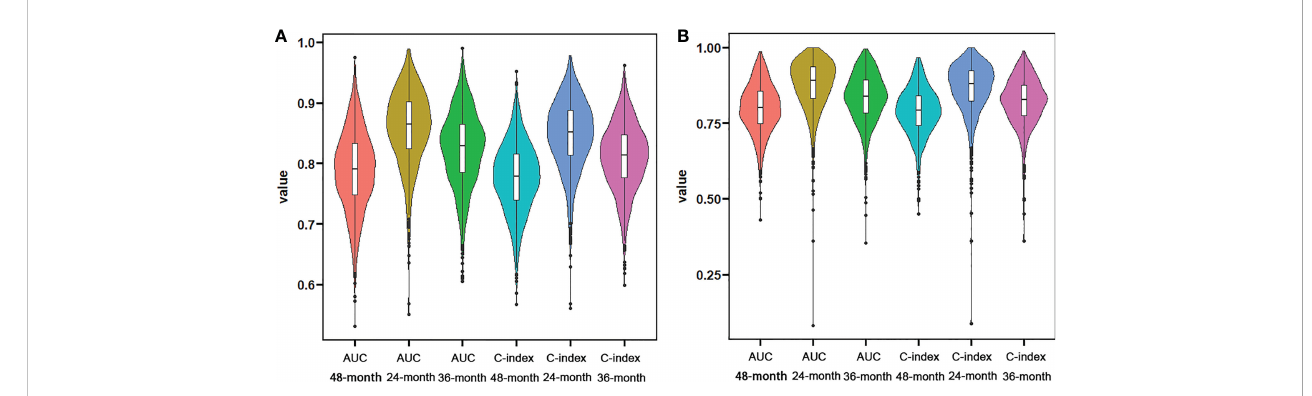
FIGURE 3 Violin plots showing the result of k-fold (k=10) cross-validation for OS analysis (A) and CSS analysis (B) .